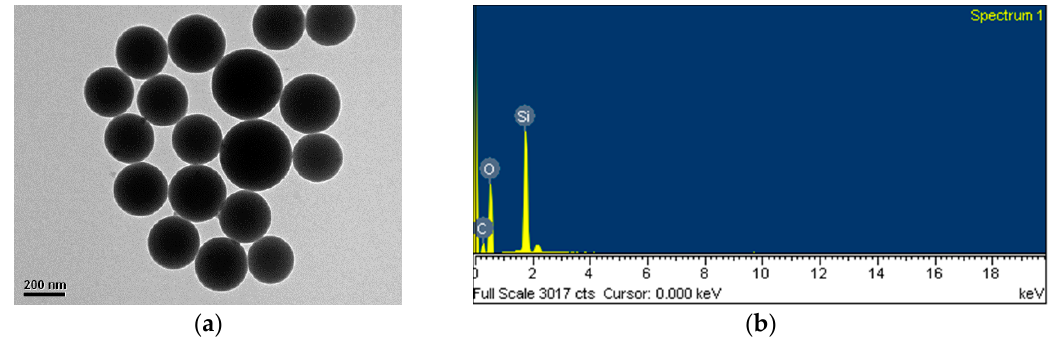
Figure 1. Transmission electron microscopy (TEM) micrograph and energy dispersive spectroscopy (EDS) for the SiO 2 spheres calcined at 700 °C. ( a ) Synthesis of SiO 2 spheres; ( b ) EDS pattern of the SiO 2 spheres.